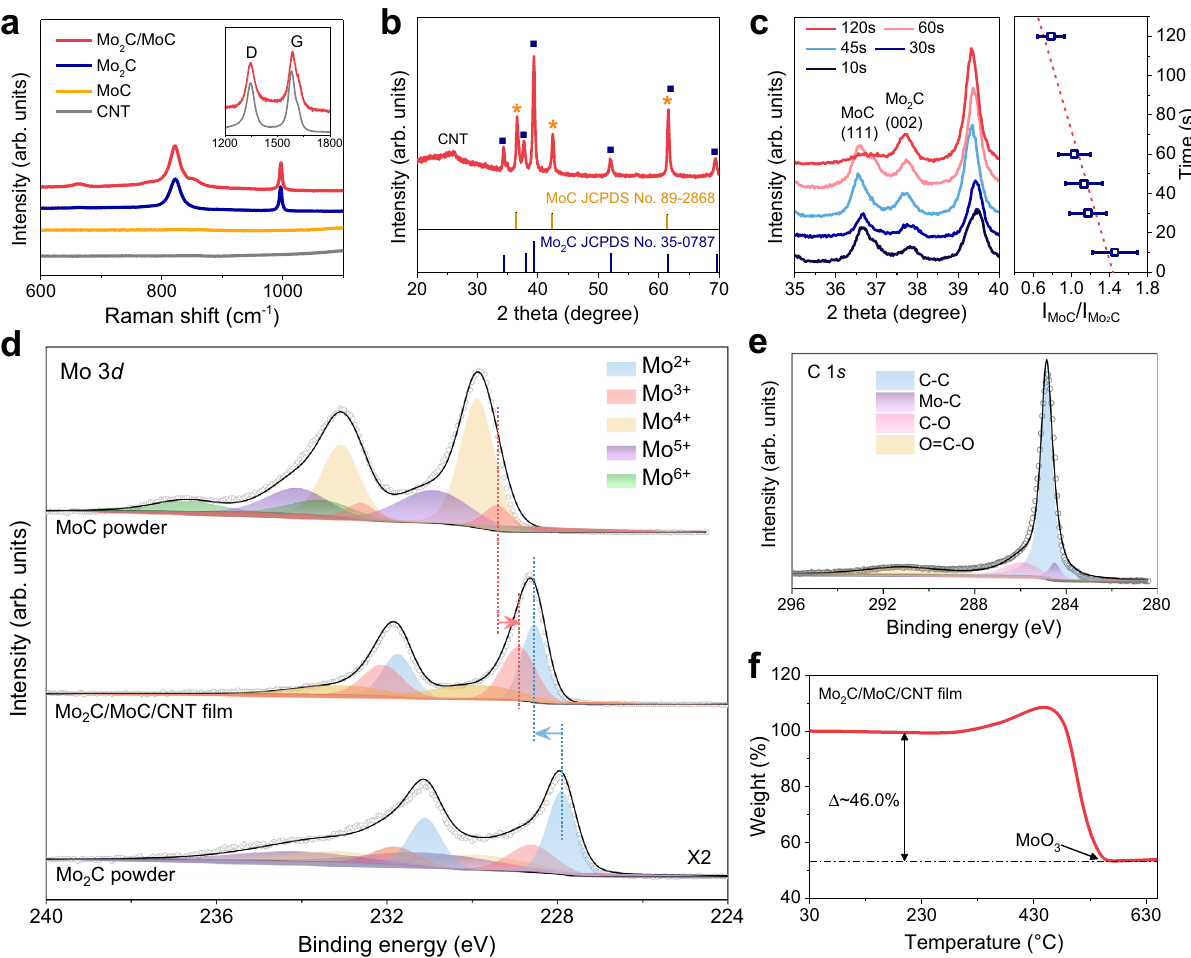
Fig. 2 Structural characterizations of as-synthesized Mo 2 C/MoC/CNT fi lms. a Raman spectra of Mo 2 C/MoC/CNT fi lm, Mo 2 C powder, MoC/CNT fi lm, and CNT fi lm. The inset shows D and G Raman peaks of CNTs. b XRD pattern of Mo 2 C/MoC/CNT fi lm. c XRD spectra of Mo 2 C/MoC/CNT fi lms synthesized with different heating time at 135 W (left panel) and the corresponding peak intensity ratios of MoC (111) to Mo 2 C (002) (right panel). The error bars represent standard deviations. d XPS spectra of Mo 3 d in MoC powder (top), Mo 2 C/MoC/CNT fi lm (middle), and Mo 2 C powder (bottom). e XPS spectra of C 1 s in the Mo 2 C/MoC/CNT fi lm. f TG analysis of Mo 2 C/MoC/CNT fi lm in catalyst particles are uniformly dispersed on the surface of the (HAADF-STEM) was performed, displaying Mo atoms because CNT fi lm without visible agglomeration. Mo 2 C/MoC particles, of a large Z value. Composite phases of Mo 2 C/MoC are formed in most catalytic particles and one typical particle is shown in Fig. 3e, where Mo 2 C, MoC, and an interfacial transition zone simultaneously exist. The inset (top right) of Fig. 3e and Supplementary Fig. 11a show the crystal structure of MoC and the atomic sites of Mo, where the angle of (111) and (220) is 90°, which is consistent with the measurement results in HAADF- STEM images and Fourier transform (FT) patterns. The inset (bottom right) of Fig. 3e and Supplementary Fig. 11b show the crystal structure of Mo 2 C, where the angles of (100) and (002) are 90° from the measurements, which is consistent with the theoretical prediction. Figure 3f shows the results of selected electron area diffraction (SAED), in which the diffraction spots/ circles of Mo 2 C (101), MoC (111), and CNT (002) suggest the composition of Mo 2 C, MoC, and CNT. Energy-dispersive spectroscopy (EDS) mapping images show the distribution of Mo, C, and N in Fig. 3g and Supplementary Fig. 12. Mo atoms are concentrated on the catalyst particles, and C atoms are concentrated on catalyst particles and CNTs. However, no clear signal of N atoms was detected, which is consistent with the XPS spectra.